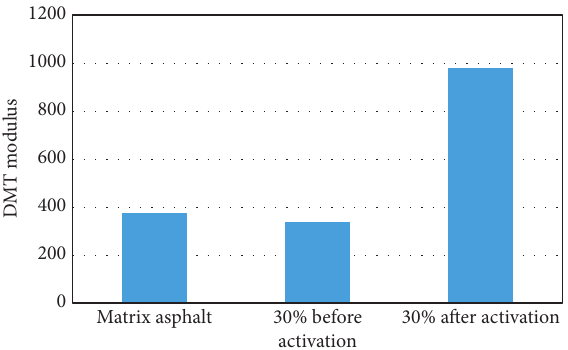
Figure 12: Effect of activation on mean modulus of DMTof BRA- modified